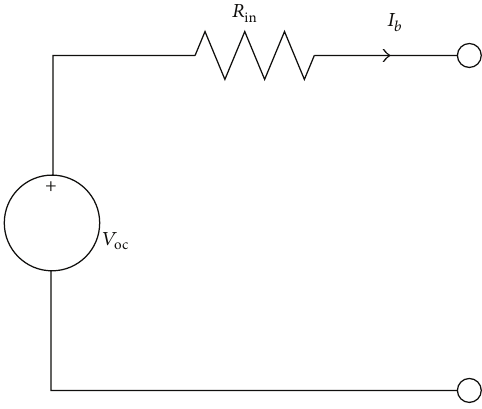
Figure 3: Equivalent circuit of simplified battery model.